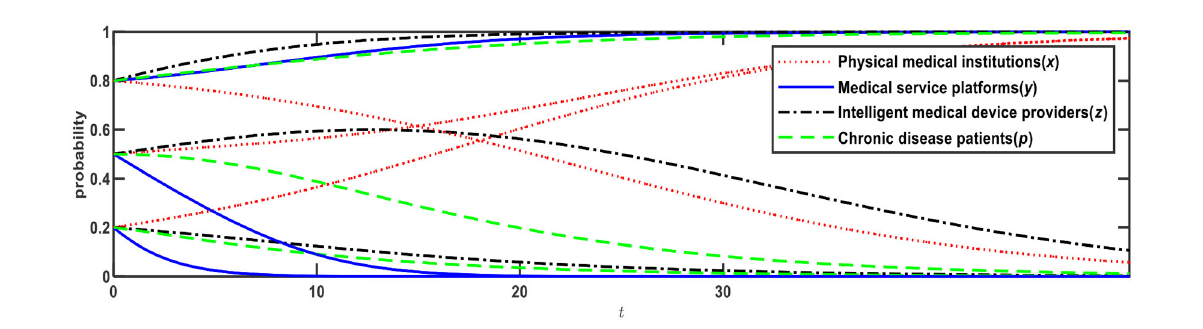
FIGURE3 Evolution of E5 (1,0,0,0) and E12